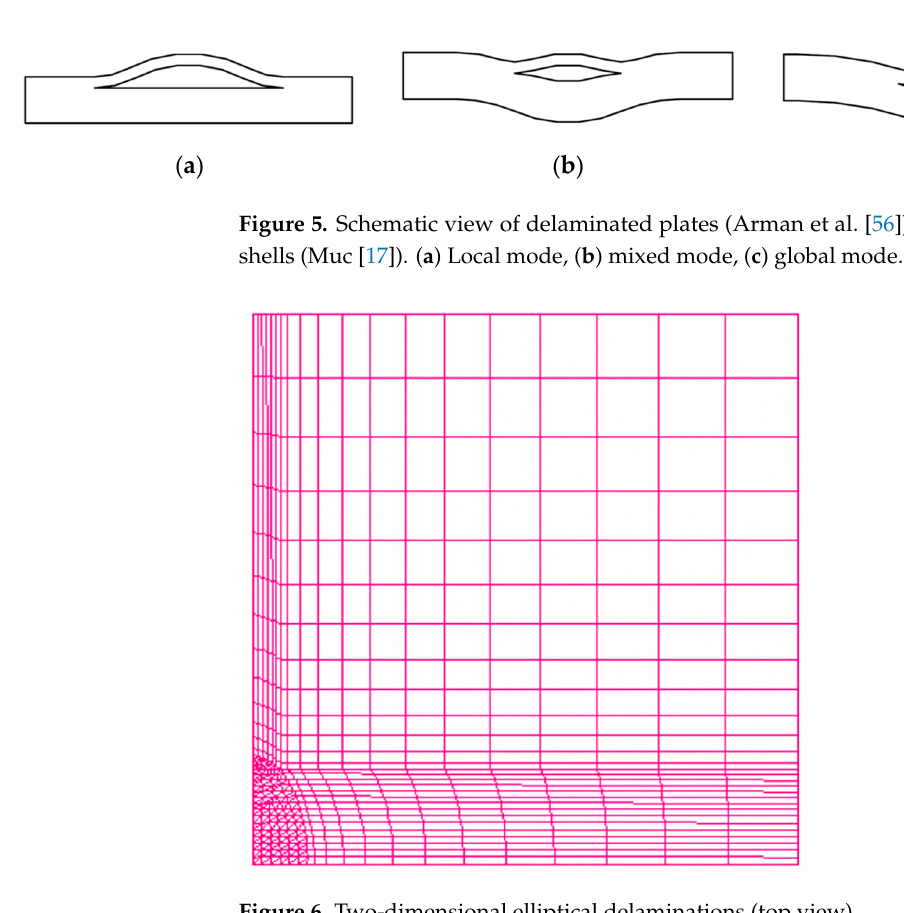
Figure 6. Two-dimensional elliptical delaminations (top Figure 6 Two-dimensional elliptical delaminations (top view).